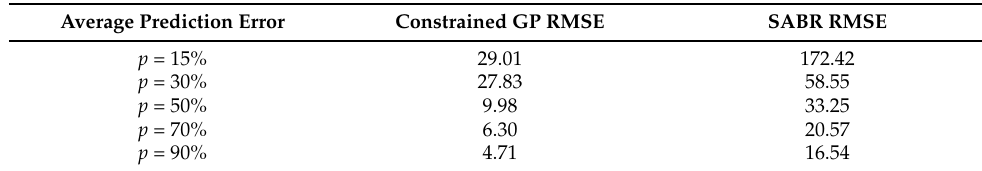
Table 7. RMSE of the constrained GP regression and SABR model with barycentric mean parameter interpolation, for increasing sizes of training